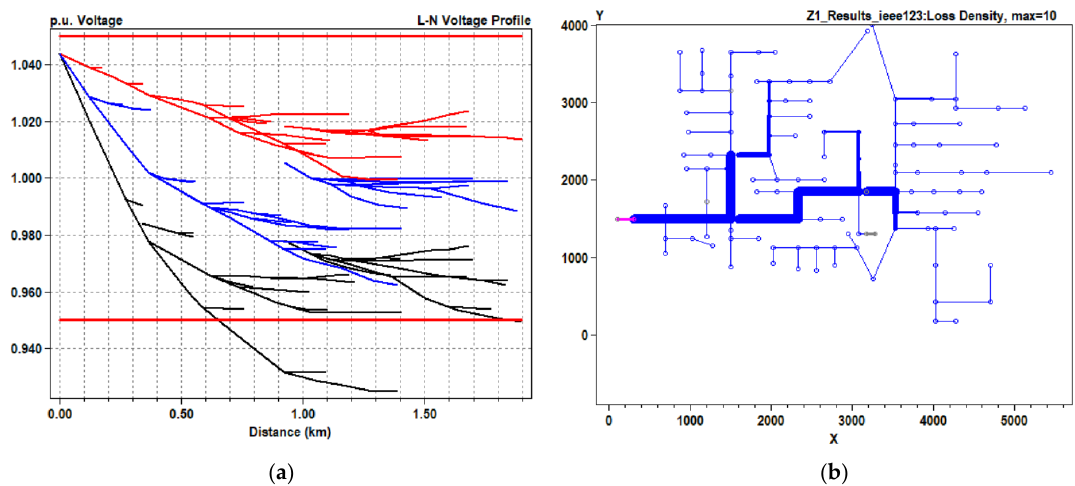
Figure 13. Impact of EVPL without PV system on the distribution network. ( a ) Voltage drop on the network, ( b ) voltage drop on the network.